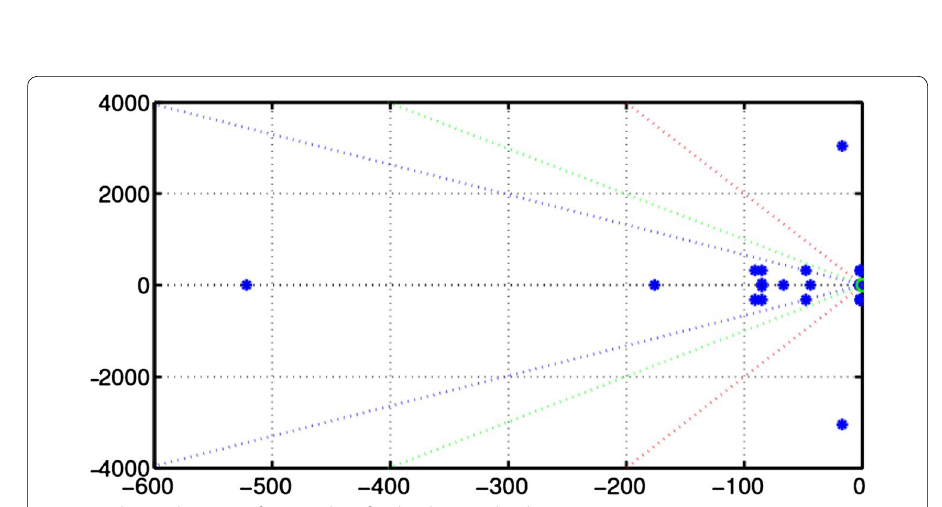
Fig. 7 Pole zero location of eigenvalues for the dynamic